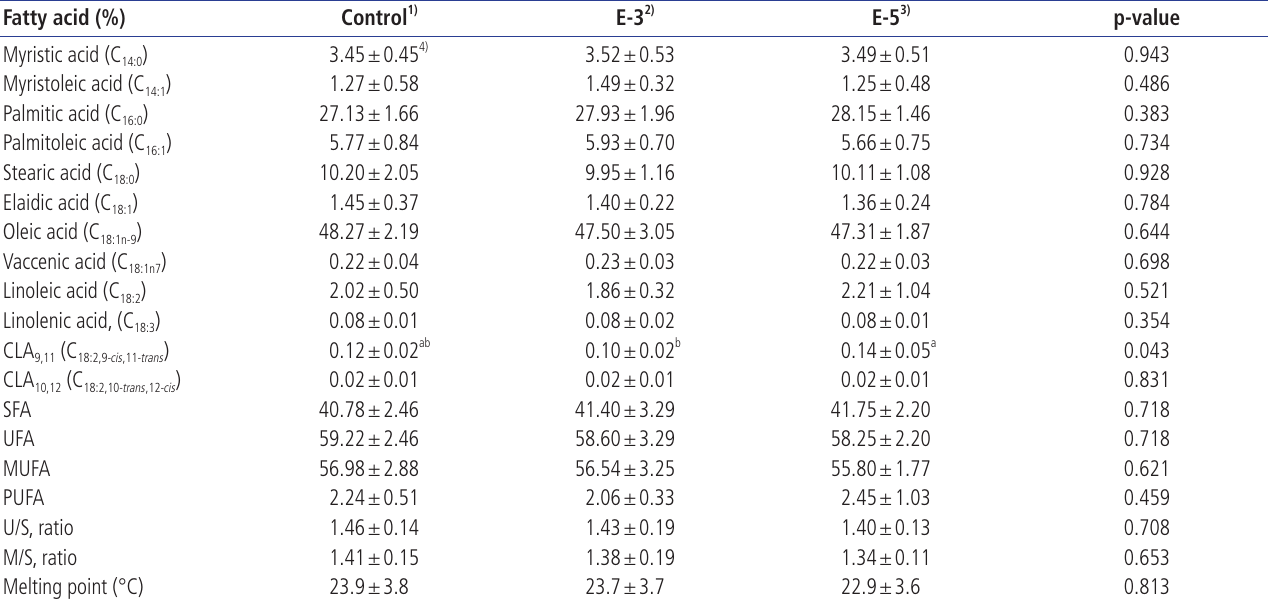
Table 7. Effects of feeding ethanol on fatty acid composition and melting point of loin muscle of finishing Korean cattle (Hanwoo) steers Fatty acid